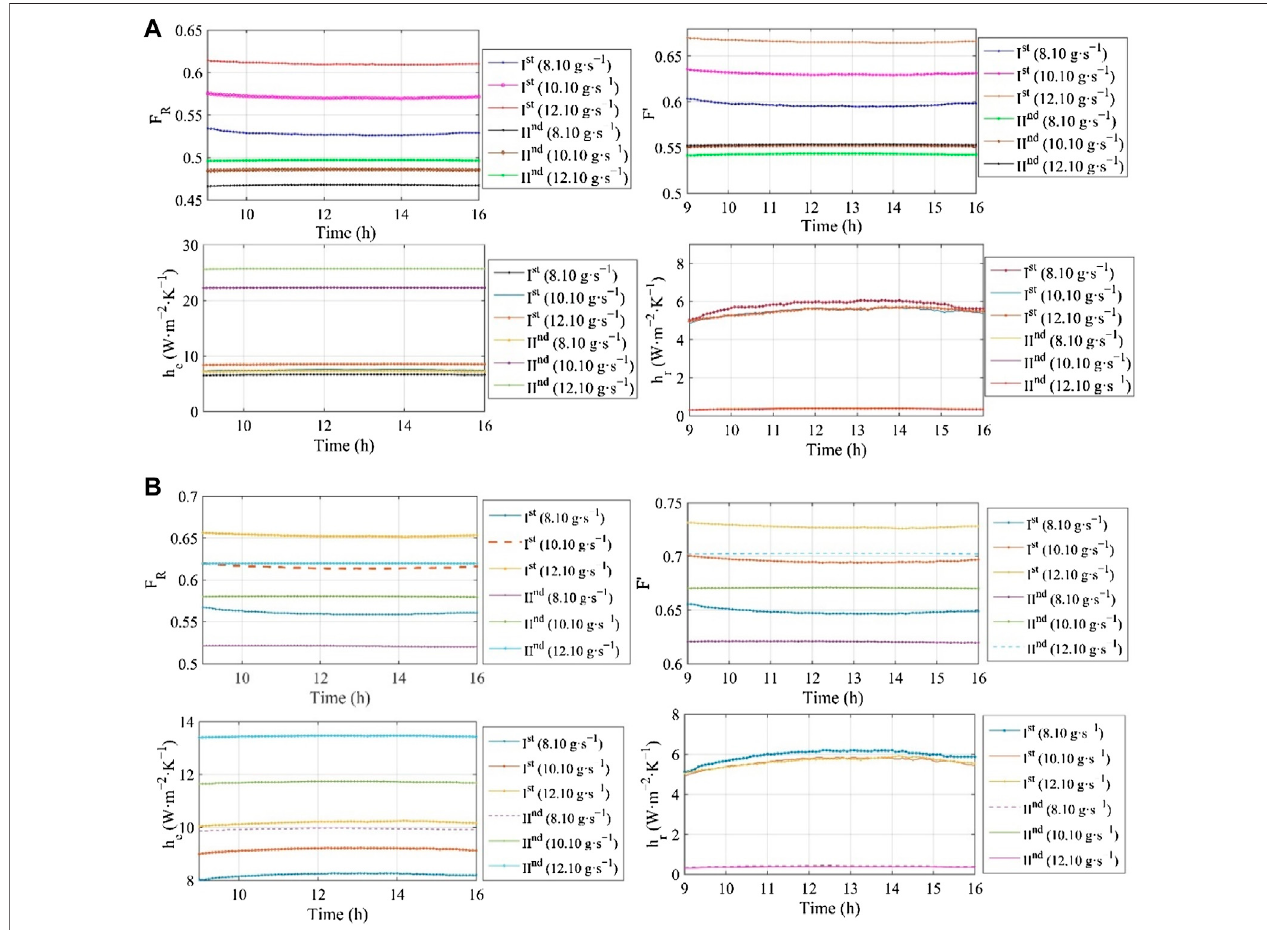
FIGURE11| Thechangeincollector( F ′ )andheatremoval( F R )factorsalongwithequivalent( h e )andradiative( h r )heattransfercoef fi cient. (A) Flatplatecollector; (B) fl at plate collector with fi ns.